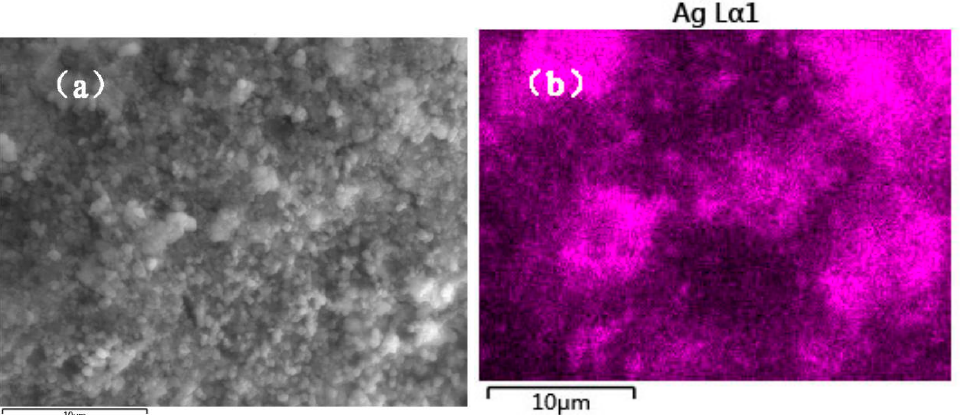
Figure 4. SEM images of MIL ‐ 101(Fe) ( a ) and Ag/AgCl/MIL ‐ 101(Fe) ( b ).